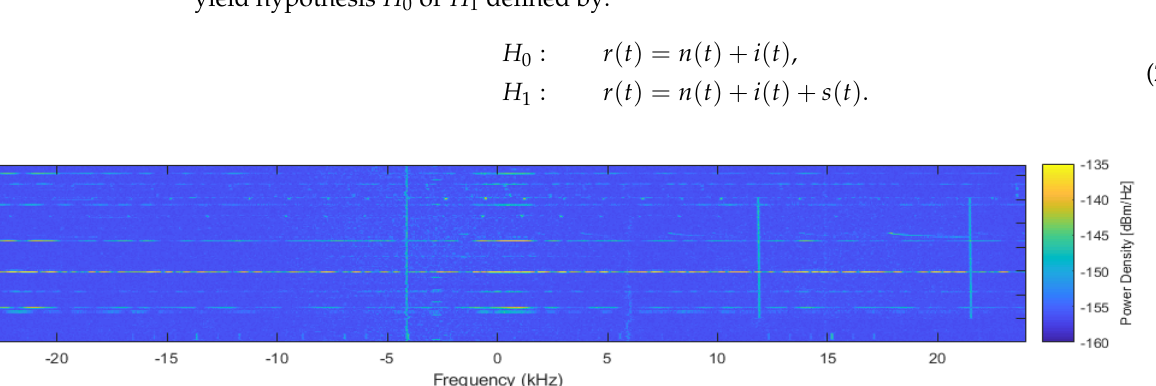
Figure 2. Spectrogram of satellite burst from 0.23 to 1.23 s received at ground station (GS) early in an overflight.